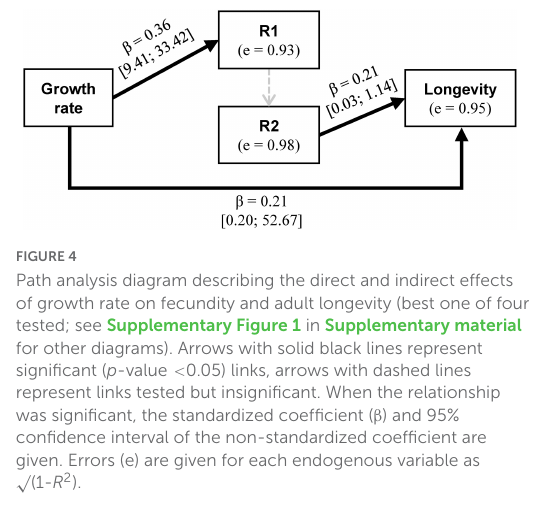
garden. Thus, if, as suspected, changes in larval growth